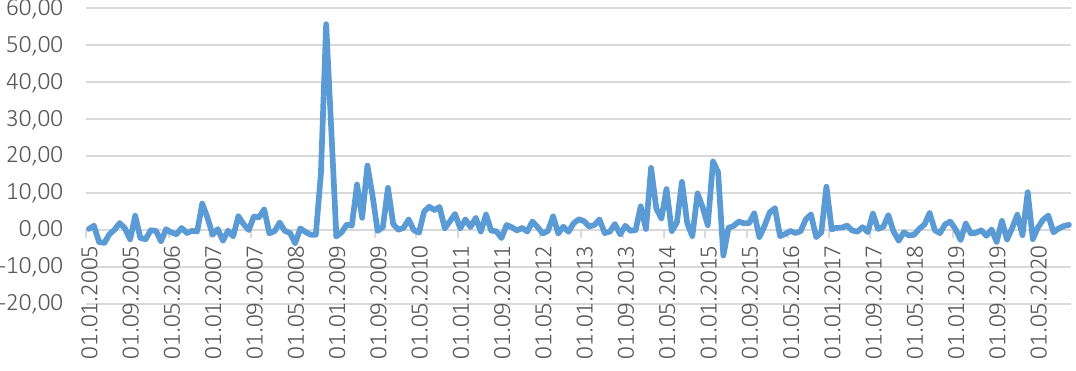
Figure 2. Monthly growth rates of Ukraine’s state debt for 2004–2020, %